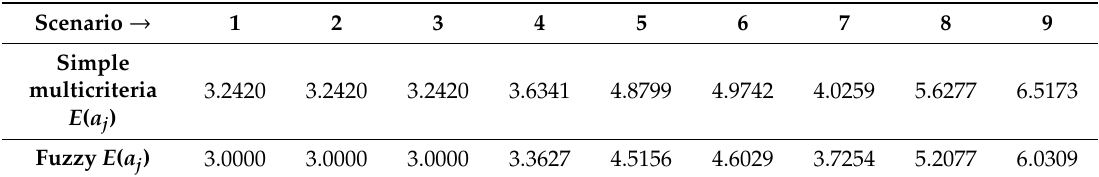
Table 14. Simple and fuzzy Bayes’ utility values.